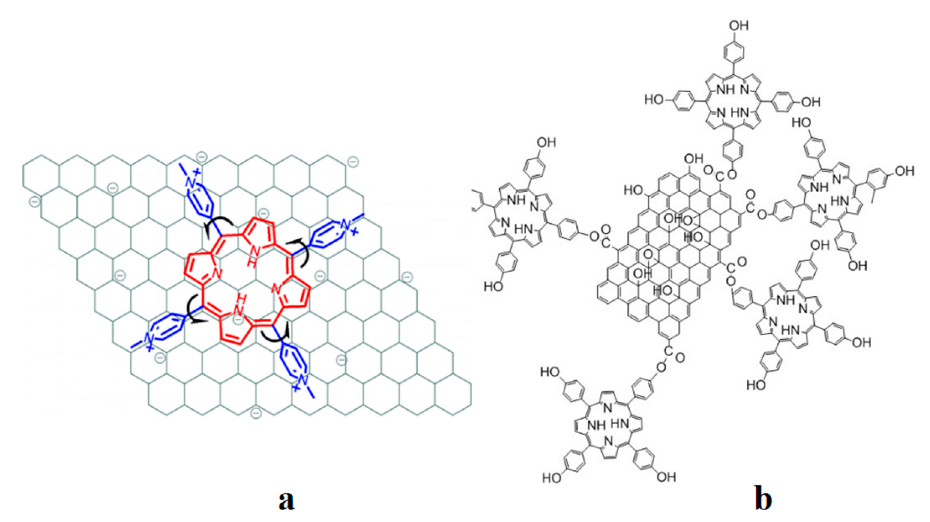
Figure 17. Molecular flattening of 5,10,15,20-tetrakis (4- N -methylpyridinyl) porphyrin p -toluenesulfonate (TMPyP) adsorbed on the chemically converted graphene (CCG) sheet ( a ) and the schematic illustration of the prepared graphene oxide–tetrakis (4-hydroxyphenyl) porphyrin (Go–THPP) ( b ). Reprinted with permission from ref [64,66]. Copyright 2009 American Chemical Society and The Royal Society of Chemistry 2015.